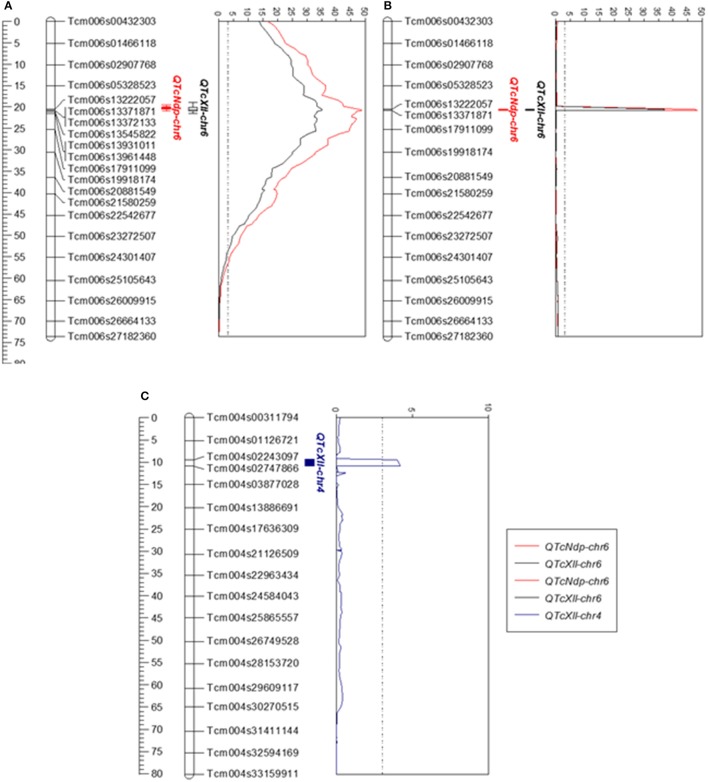
Logarithm of odds (LOD) score peaks for linkage groups VI (A,B), and IV (C), which were significantly associated with resistance to CWC in the F1 population (“TSH 1188” vs. “CCN 51”). The ruler on the left side of the graph shows the position of SNP markers every 5 cM. The graph in (A) shows the LOD score plots obtained by interval mapping of NDP and XLL on chromosome VI. The graphs in (B,C) show the LOD score plots obtained by multiple QTL mapping of NDP and XLL on chromosomes VI and IV, respectively. The dotted line indicates the LOD significance threshold level of 3.0, calculated by permutation testing (P < 0.05). The positions of QTcNdp-chr6, QTcXll-chr6 and QTcXll-chr4 are shown with inner and outer vertical bars for the 1-LOD and 2-LOD support intervals, respectively.